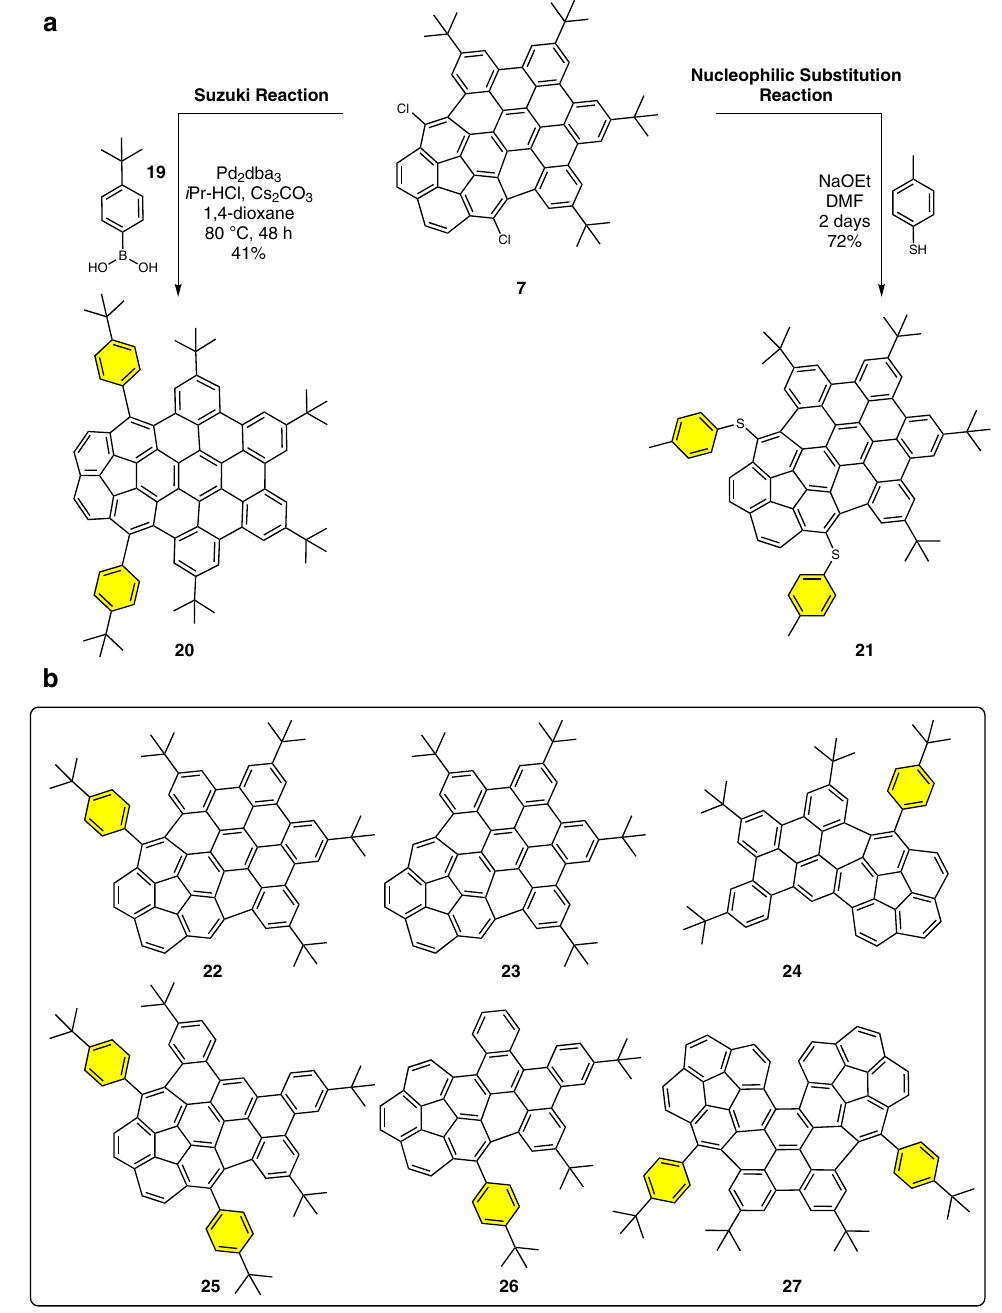
Fig. 4 | Nanographene functionalization. a Suzuki and nucleophilic aromatic substitution reactions for scaffold functionalization. b Chemical structures of modi fi ed